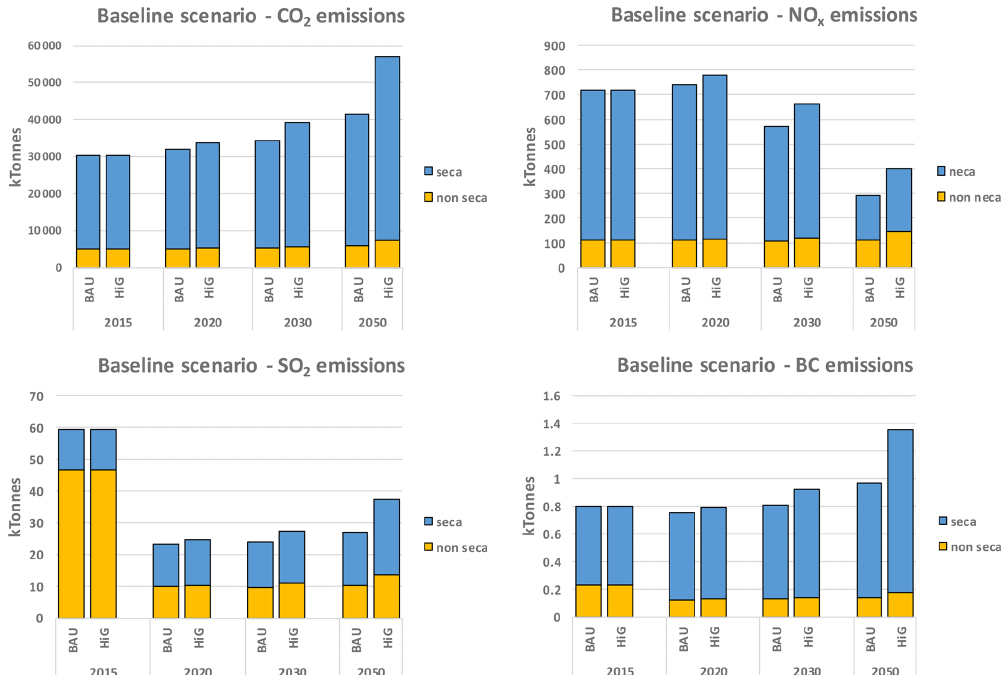
Figure 2. CO 2 , NO x , SO 2 and BC emissions for 2015 and Baseline scenario results for 2020, 2030 and 2050, which have been further split into SECA and non-SECA parts of domain